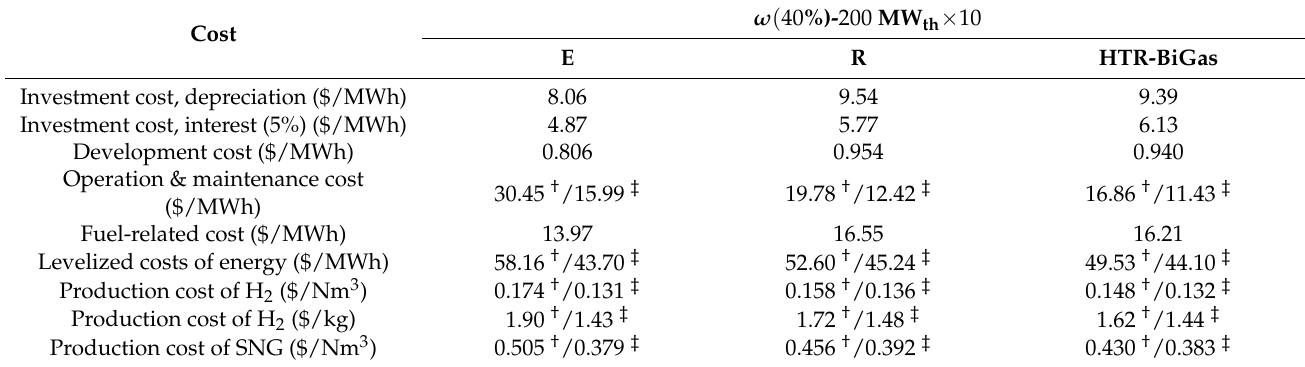
Table 8. Results of economic evaluations of HTR-BiGas and other designs.